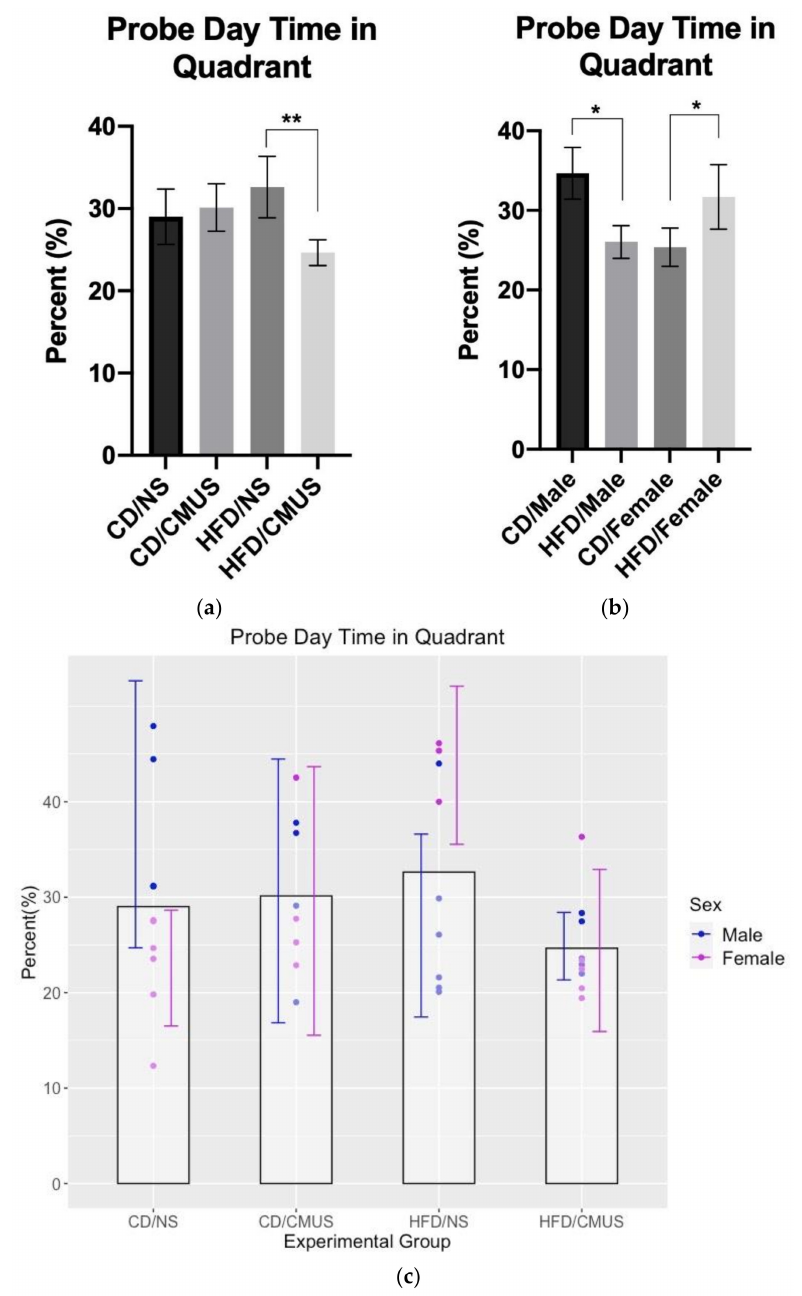
Figure 9. ( a ) Percent time spent in the target quadrant on the probe trial (day 7). Animals experiencing NS spent significantly more time in the target quadrant as compared to those experiencing CMUS ( p < 0.05). In the high-fat condition, those mice experiencing CMUS spent significantly less time in the target quadrant than those with NS (** p < 0.01). ( b ) Percent time spent in the target quadrant on the probe trial (diet*sex). Male mice given a HFD spent significantly less time in the target quadrant than male mice on a CD ( p = 0.015); female mice given a CD spent significantly less time in the target quadrant than female mice on a HFD diet ( p = 0.03) (* p < 0.05). ( c ) Sex differences in percent time spent in the target quadrant on the probe trial (experimental groups (Figure 9a)). In female mice given HFD, those receiving CMUS spent significantly less time in the target quadrant compared to those given NS ( p =